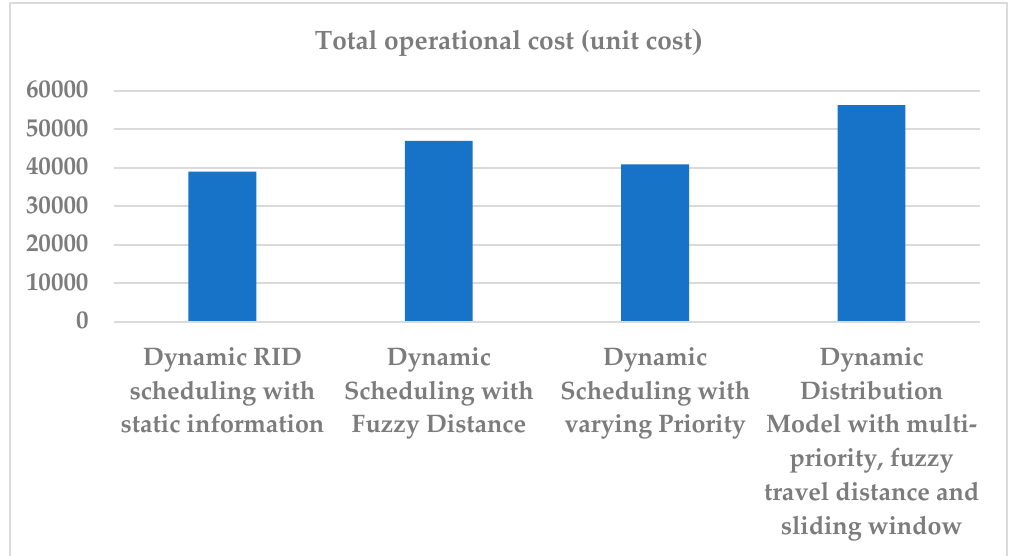
Figure 5. Operational cost plots of different dynamic RID Models.